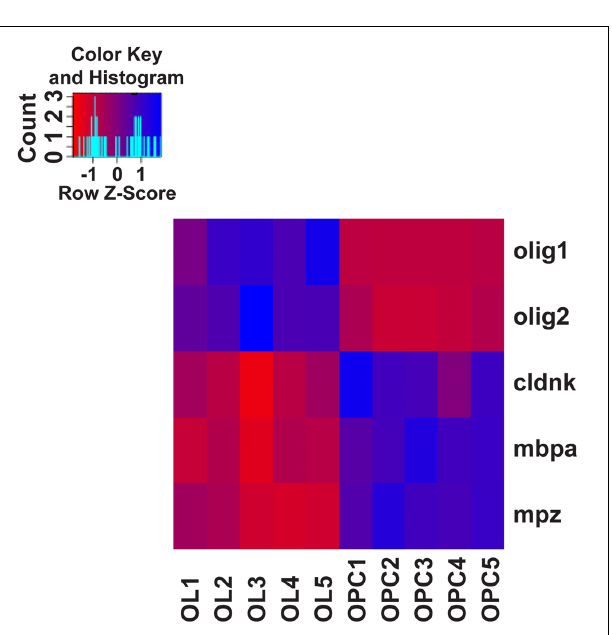
FIGURE 5 | Heat-map of canonical oligodendroglial marker gene expression. Assessing the gene expression levels of well-described differentiation markers of the oligodendroglial lineage from transcriptome/RNAseq data confirms the identity and differentiation status of FACsorted cell populations: Based on the expression of the oligodendrocyte lineage markers olig1 and olig2 and the mature OL markers cldnk , mbpa and mpz , biological replicates of OPC and OL populations are clearly separated. Gene expression levels of the chosen genes are standardized by z-transformation allowing the direct comparison of up- and